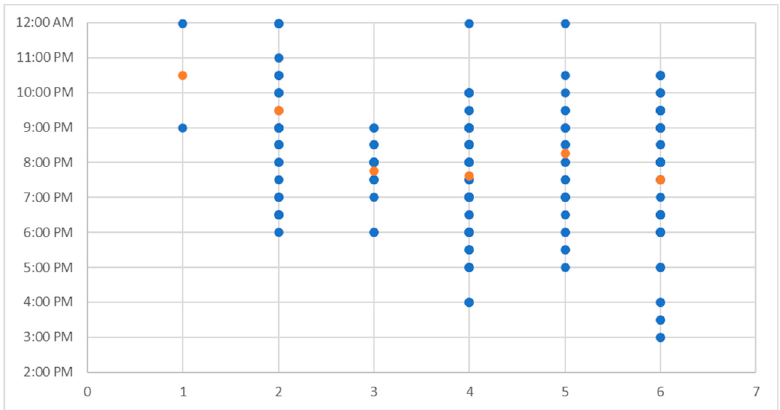
Figure 8. Summary of estimated times when the sea breeze was observed to arrive at the SRS based on 30-min visual observation of radar imagery and grouped by synoptic case (blue) and the average time that the sea breeze arrived for each synoptic case (orange).